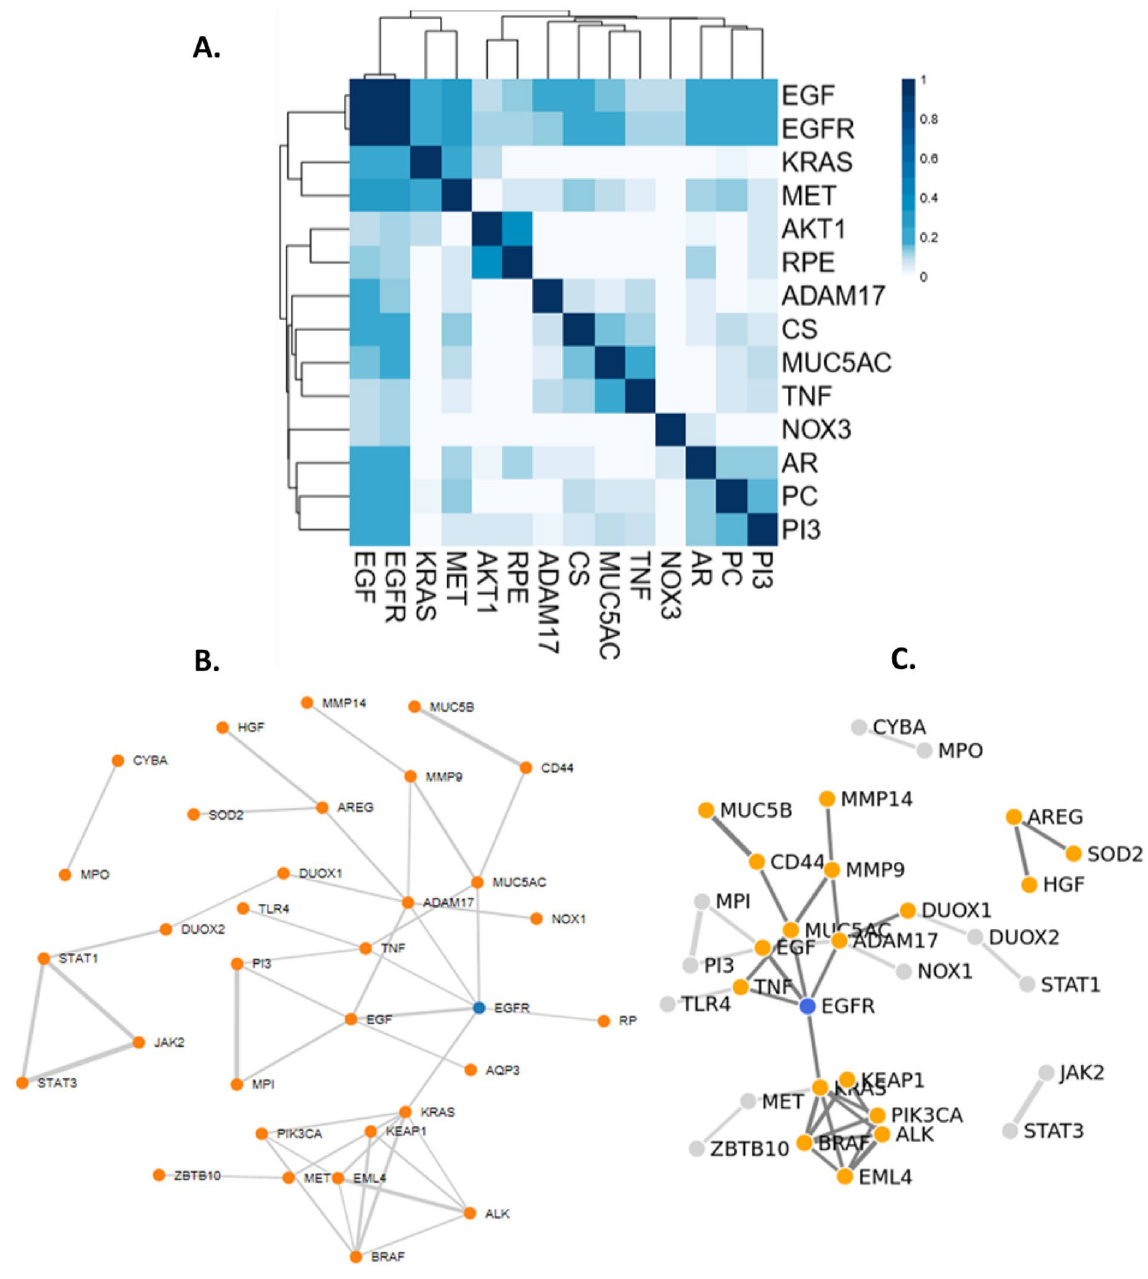
Figure 2. ( A ) Cosine-similarity matrix for KE1 seed genes. ( B ) Network plot established from the document corpus using a cosine similarity threshold > 0.1. ( C ) Network plot established using the curated document corpus and a cosine similarity threshold >